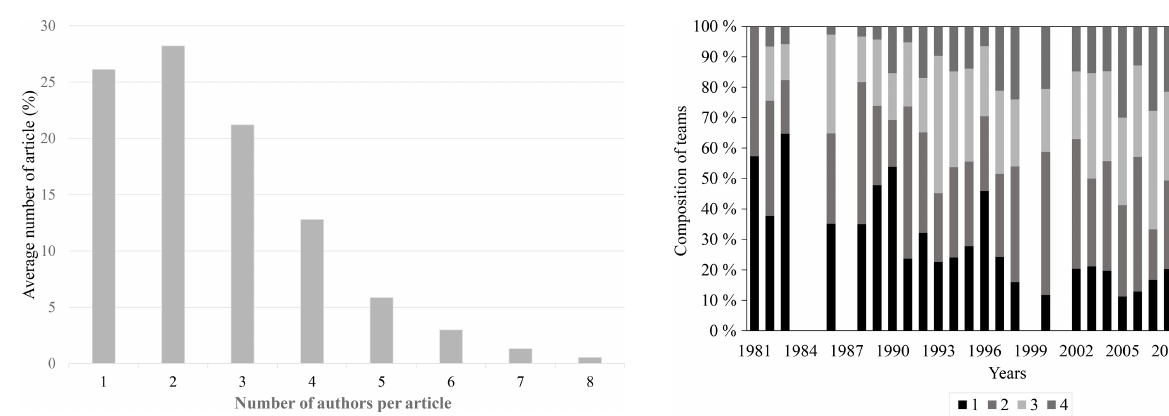
Figure 3. Time changes in the ratio of articles prepared with the participation of a different set of co-authors and published in ICCE edited issues. Legend: Articles prepared by: 1 – individual authors; 2 – co-authors from one organization; 3 – co-authors from one coun- try (national team); 4 – international